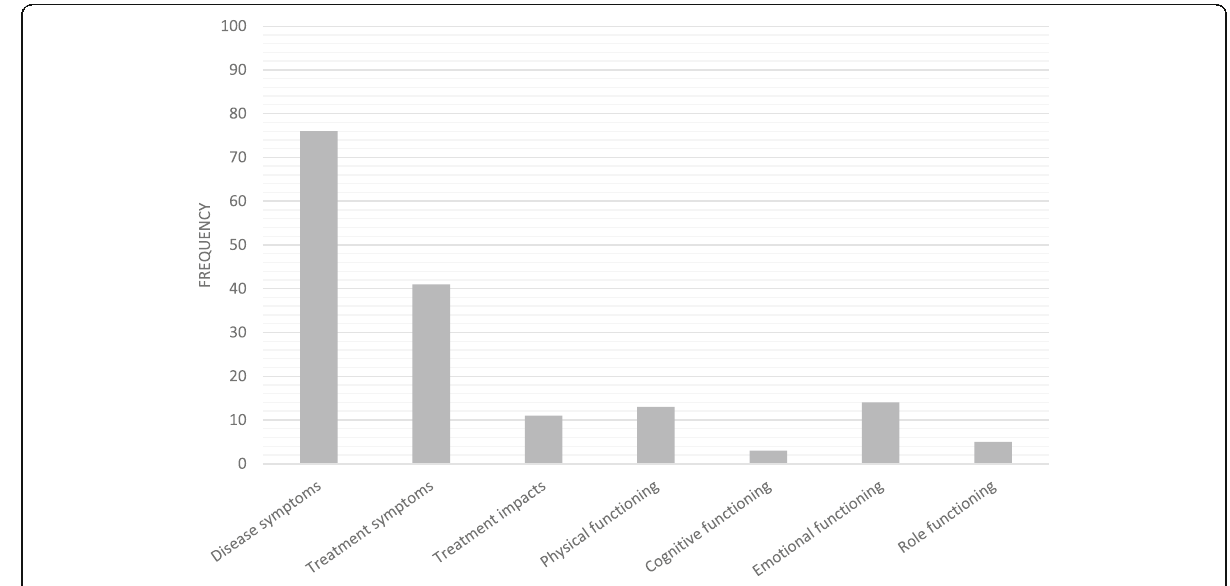
Fig. 3 Frequency of Concepts Discussed by